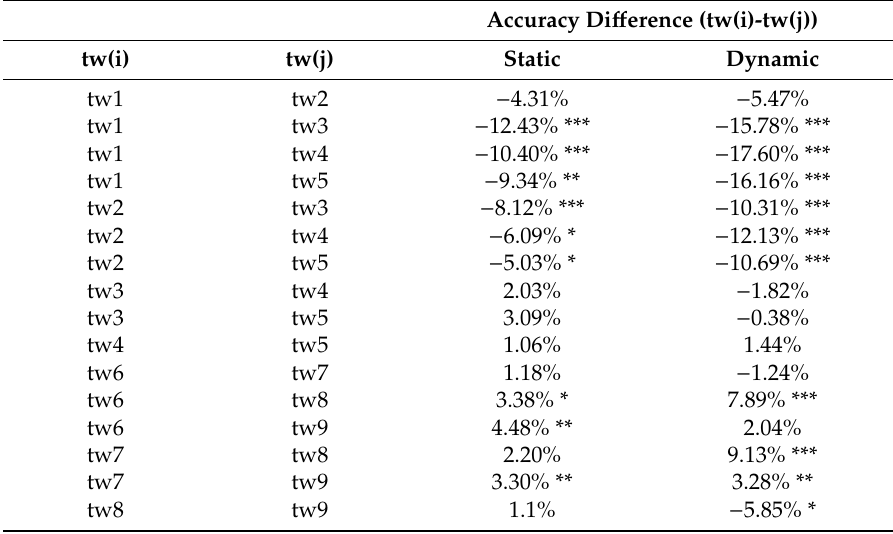
Table 4. The di ff erence between di ff erent time windows on accuracies at di ff erent